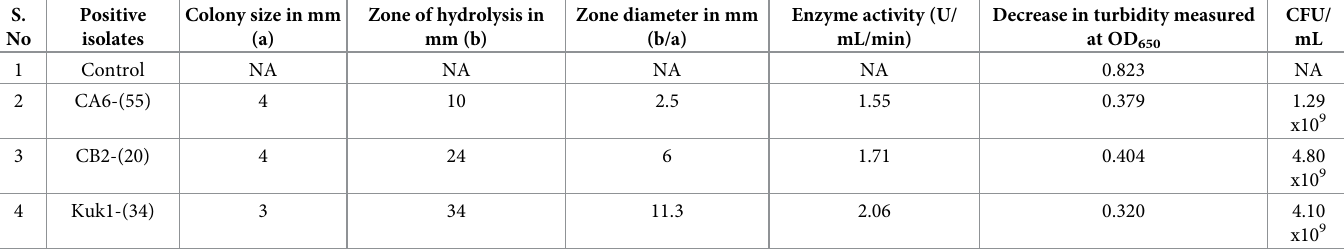
Table 2. Enzyme activity and CFU count of positive bacterial isolates.